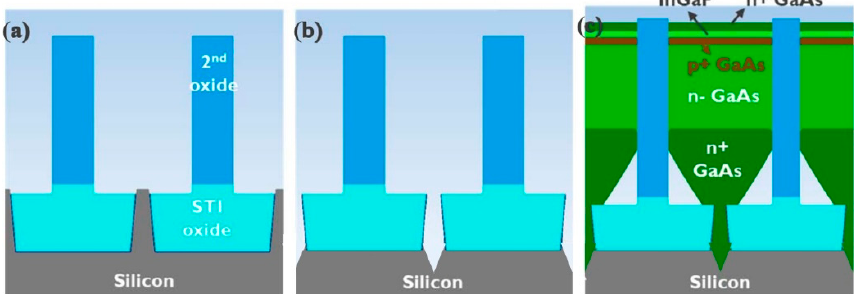
Figure 1. Schematic of the double trench-patterned oxide template ( a ) after opening the wide trench in the second oxide, ( b ) after silicon recess etch to create a {111}-faceted V-groove at the bottom of the narrow trench and ( c ) after epitaxial deposition of a HBT layer stack.